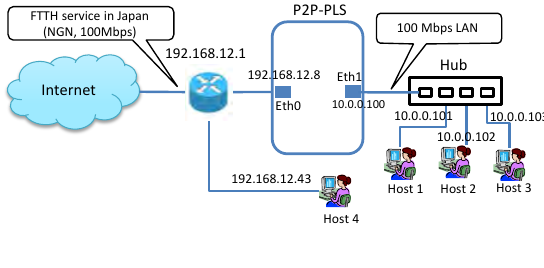
Fig. 4. Network environment and